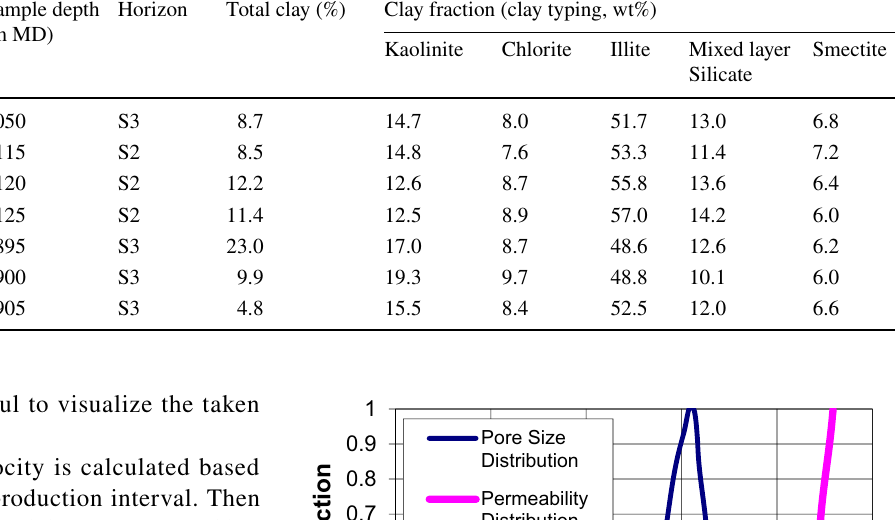
Sample depth (m MD)